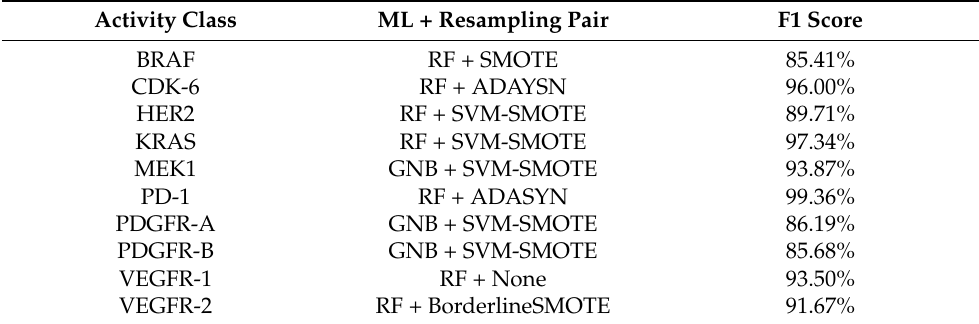
Table 4. Best machine learning classifier and resampling method pair for each activity with their respective F1